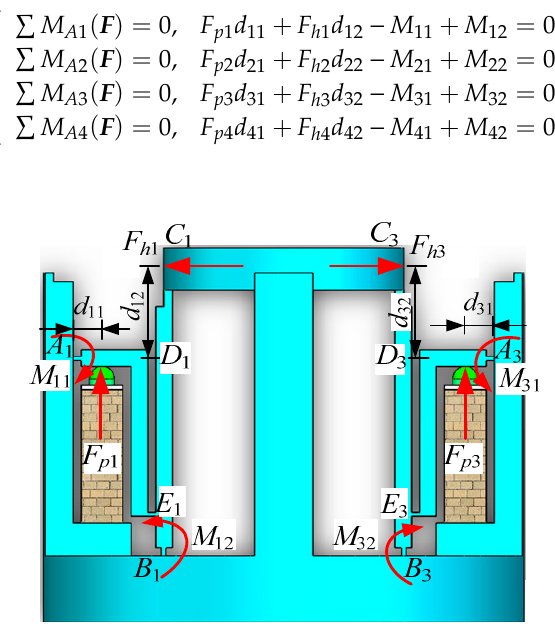
Figure 5. Force diagram of displacement amplification mechanism.